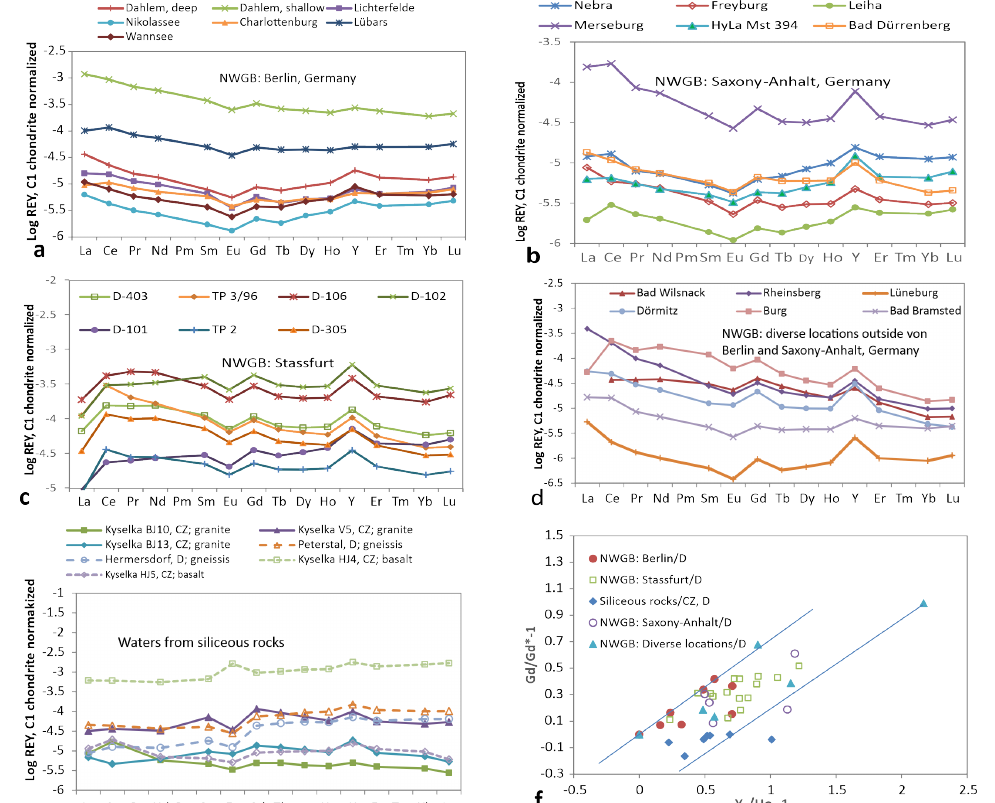
Figure 8. REY in groundwater from wells with temperatures less than 20 ◦ C. Groundwater from the Permian North-Western German basin (NWGB): ( a ) Berlin area; ( b ) Saxony-Anhalt; ( c ) Saline waters from observation wells above the closed salt mine of Stassfurt (NWGB); ( d ) saline waters from various formations of all over NWGB outside Berlin and Saxony-Anhalt [78,79]; Upper Permian: Lüneburg, Dörmitz, Bad Bramstedt; Triassic/Keuper: Bad Wilsnack; Triassic/Bunter: Rheinsberg, Burg; Lower Tertiary: Bad Schwartau; ( e ) Wells at Kyselka in the Duopowski Mts, Czech Republic [80], and Black Forest, Germany [63]; ( f ) Correlation of Gd and Y anomalies. Average slope is about